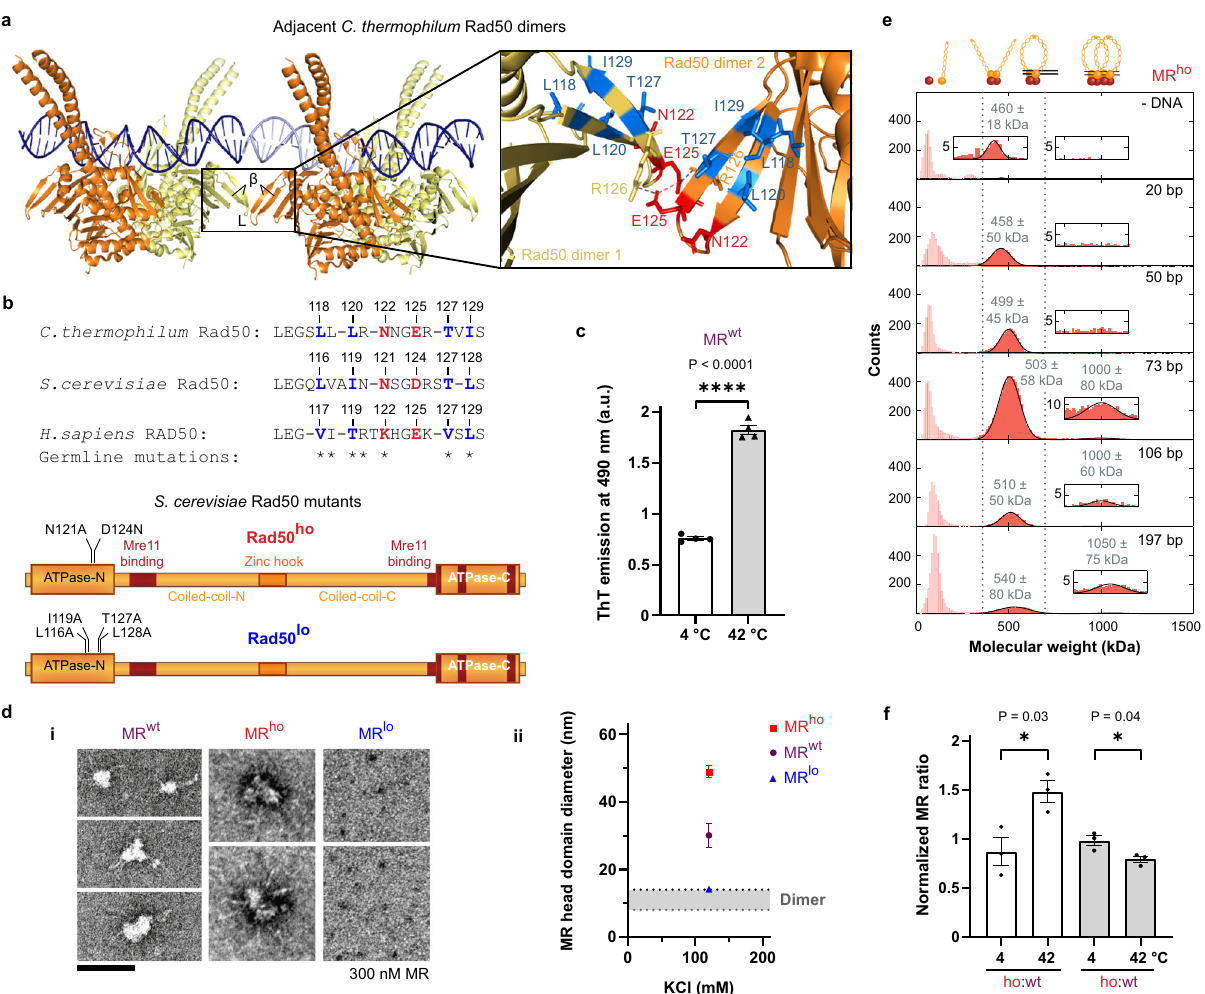
Fig. 3 Mutagenesis of conserved Rad50 interface regulates MR oligomerization. a Crystal structure of two C. thermophilum ( Ct ) Rad50 dimers bound to one oligonucleotide molecule each (PDB: 5DAC 48 , 10.2210/pdb5dac/pdb) used to generate a plausible interaction model as guide for validation by mutagenesis. Possible interactions of adjacent Rad50 dimers on DNA via a small beta-sheet ( β ) and its connecting loop (L) protruding from the Rad50 head domain (rectangle), especially if bound DNA was continuous. Zoom-inset shows red/blue residues mutated in the S. cerevisiae ( Sc ) Mre11-Rad50 ho/lo variants. Gray dotted line: salt bridge between E125 and R126 residues of adjacent Ct Rad50 dimers (spacing 3.8 Å within crystal). Red dotted line: repulsive E125 residues of adjacent Ct Rad50 dimers are spaced by 4.8 Å within the crystal, but could come closer on continuous DNA and in solution. b Sequence alignment of the Ct , Sc, and H. sapiens Rad50 beta-sheet motifs. Color code as in a . * indicates germline point mutations listed on ClinVar/MedGen for cancer-predisposed humans. Cartoons show multiple point mutations introduced in Sc Rad50 to disrupt electrostatic (Rad50 ho ) or hydrophobic (Rad50 lo ) interactions (Supplementary Fig. 5a). c Thio fl avin T (ThT) fl uorescence of Sc MR wt indicates beta-sheet rich higher-order structures (Supplementary Fig. 5e). Mean ± SEM, n = 4 independent experiments, unpaired two-tailed t -test, a.u., arbitrary units. d (i) Representative TEM of Sc MR wt/ho/lo as in Fig. 1a – v. (ii) Quanti fi cation of mean head domain diameters ± SEM of Sc MR wt/ho/lo oligomers from (i) along their longest axis. n MR-wt = 30 molecules, n MR- = 72, and n = 46. Gray area indicates diameter range of ~8 – 14 nm measured for Sc MR wt dimers. Scale bar: 100 nm. e Molecular mass distributions ho MR-lo from mass photometry show better Sc MR ho binding to longer oligonucleotides (100 nM base pairs). Cartoons illustrate species in peaks. Measured molecular weight (MW, kDa) ± SD in gray. Zoom-insets show MW range where a peak of two MR dimers bound to one DNA molecule would be expected and was fi tted where possible (Supplementary Fig. 3b). n = 3 independent experiments. f Quanti fi cation of Sc MR wt/ho pelleting assays at 4 or 42 °C (see Supplementary Fig. 5c). Sup. supernatant. Higher temperature promotes oligomerization. Mean ± SEM, n = 3, unpaired two-tailed t -tests.